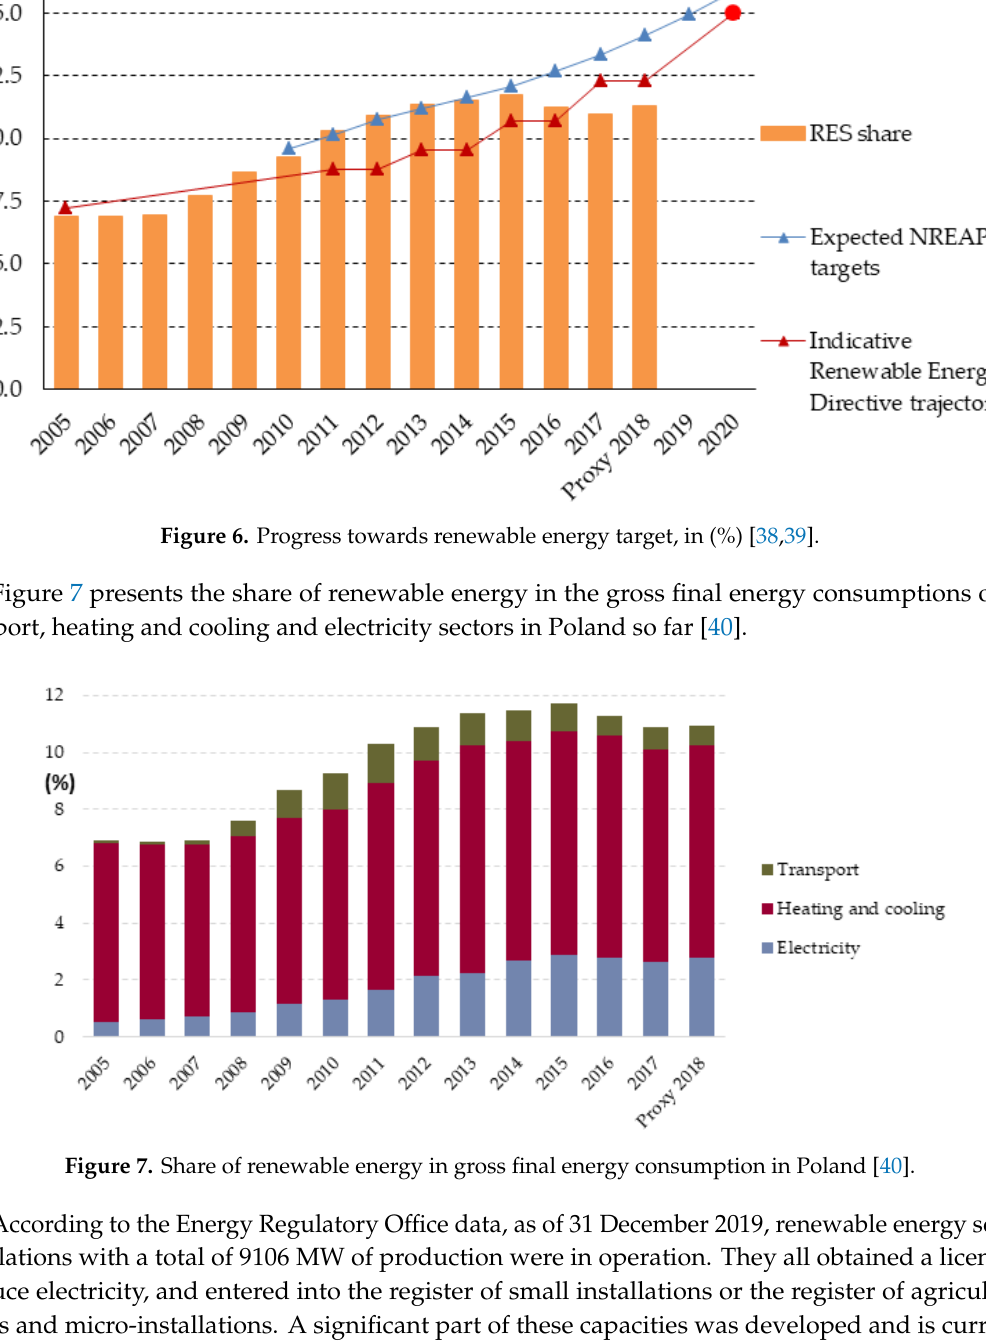
Table 8. RES-E installed capacity in Poland, in (MW) [40].